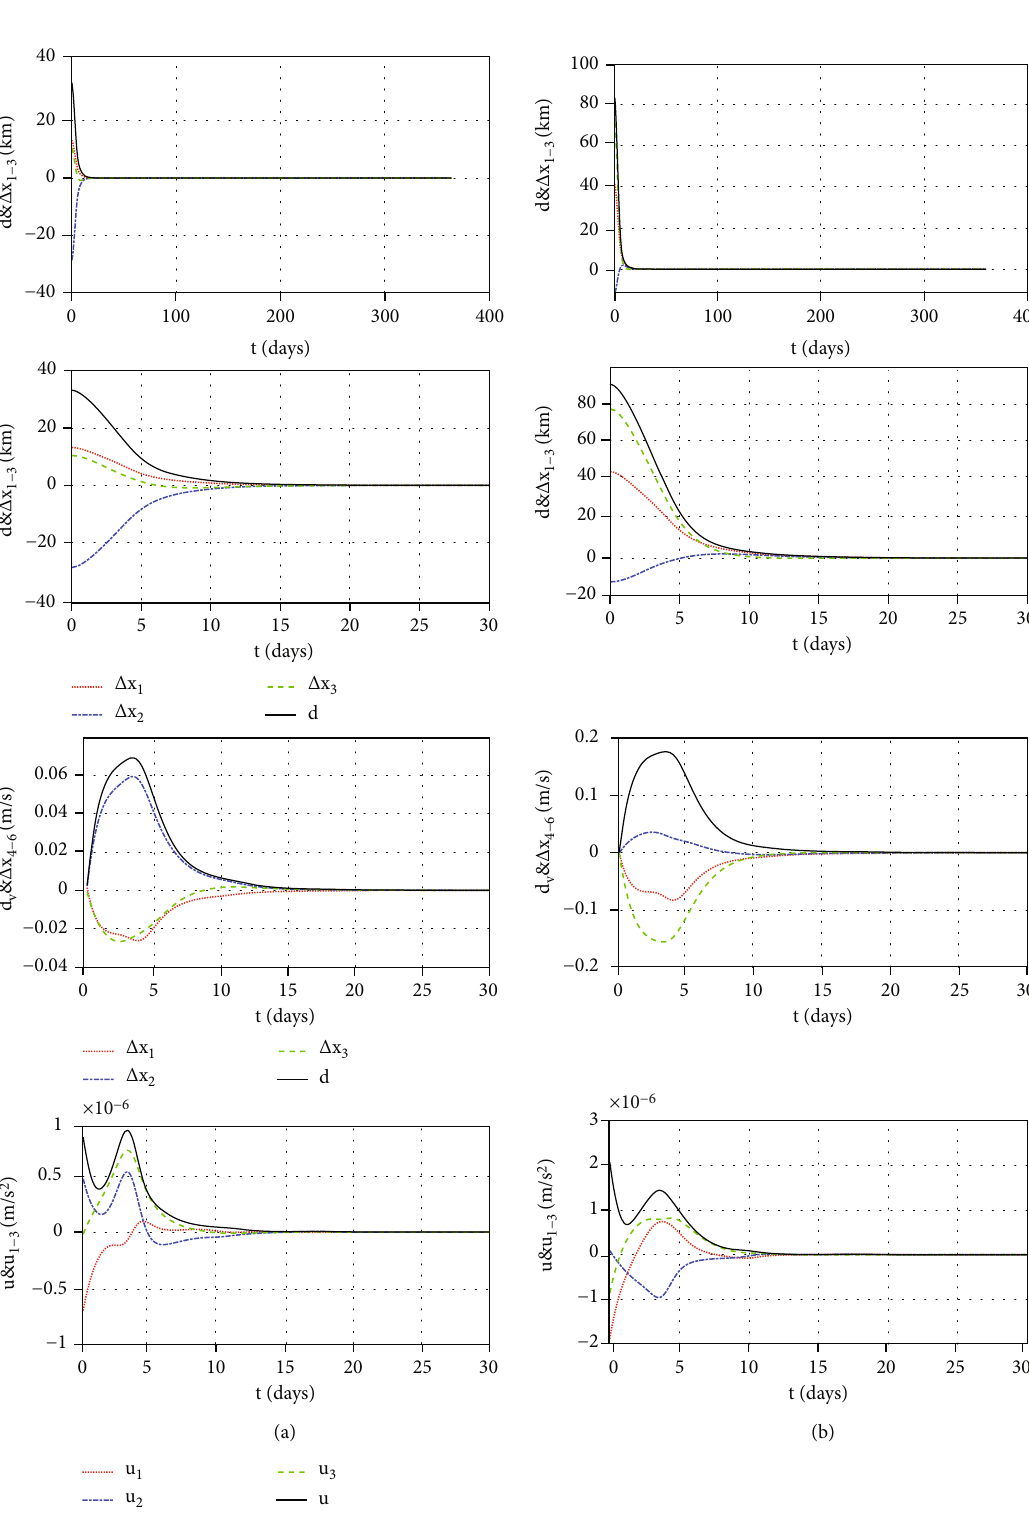
Figure 4: The position deviations, velocity deviations, control inputs, and the zoomed fi gures when the LQR (a) and OSMC controllers (b) are applied to the 2:1